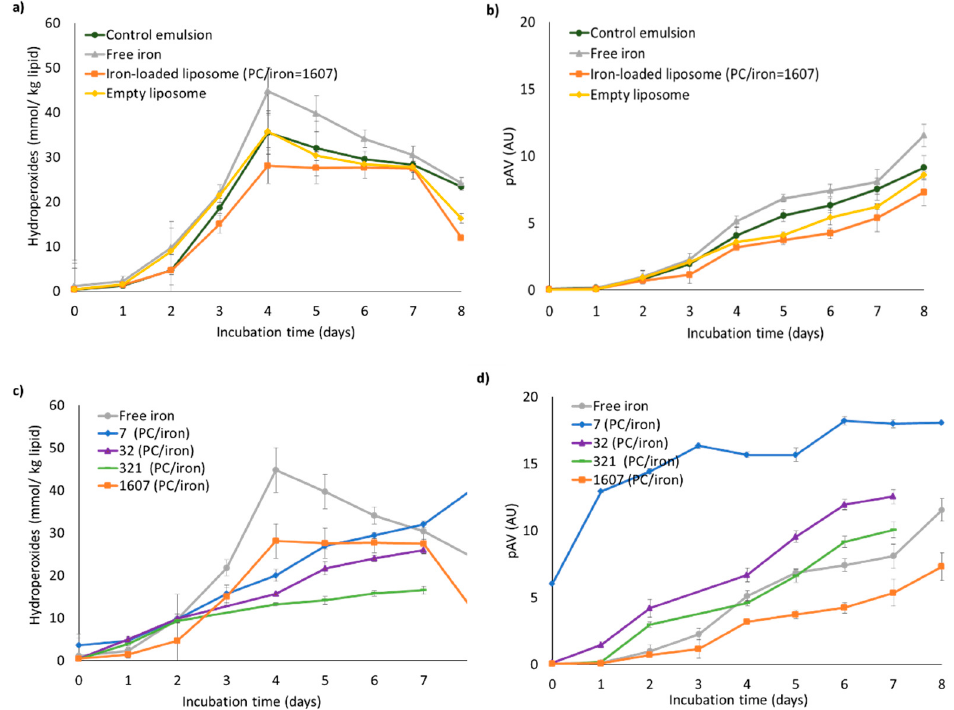
Figure 5. ( a , c ) Hydroperoxide concentration and ( b , d ) para-anisidine values (pAV). Top panels: control emulsion, emulsion with empty liposome, emulsion with iron-loaded liposome, and emulsion with free iron; bottom panels: emulsion with free iron and emulsions containing the following PC-to-iron ratios: 7, 32, 321, or 1607. All emulsions were incubated at 40 °C under slow rotative agitation. in all iron-containing emulsions the concentration was 0.10 mM. Error bars represent standard deviations (n = 4).